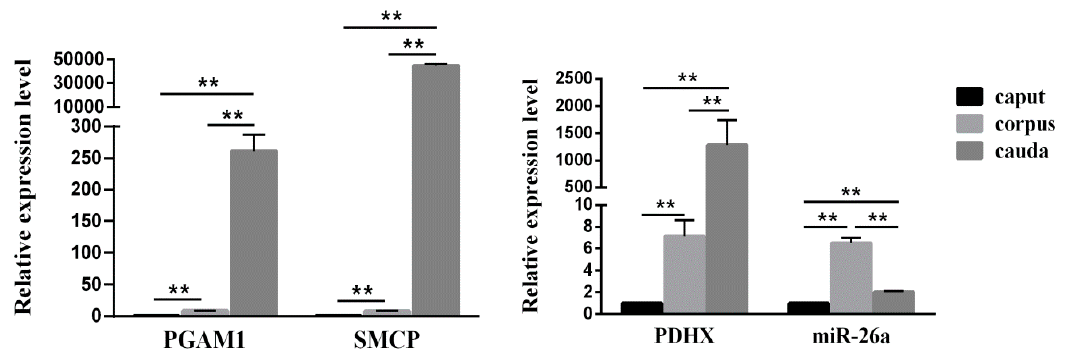
Figure 3. The expression levels of PGAM1 , SMCP (left) and miR-26a, PDHX (right) in the epididymal caput, corpus and cauda sperm. “**” indicates statistical significance at P < 0.01. 3.3. Comparison of miR-26a and PDHX Expression in Epididymal cauda, Ejaculated and Frozen-Thawed Boar Sperm.